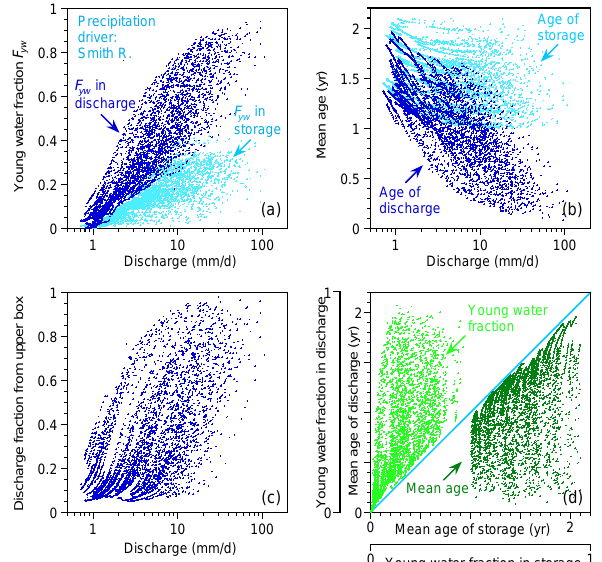
Figure 4. Daily values of young water fractions F yw (a) and mean water ages (b) in storage (light blue) and discharge (dark blue) in the two-box model with reference parameter values and Smith River (Mediterranean climate) precipitation. The young water fraction and mean age are both highly scattered functions of discharge (a, b) , as is the fractional contribution from the upper box to stream- flow (c) , reflecting the effects of variations in antecedent rainfall. The average age and F yw of water in discharge are strongly biased, and highly scattered, measures of the same quantities in storage (d)